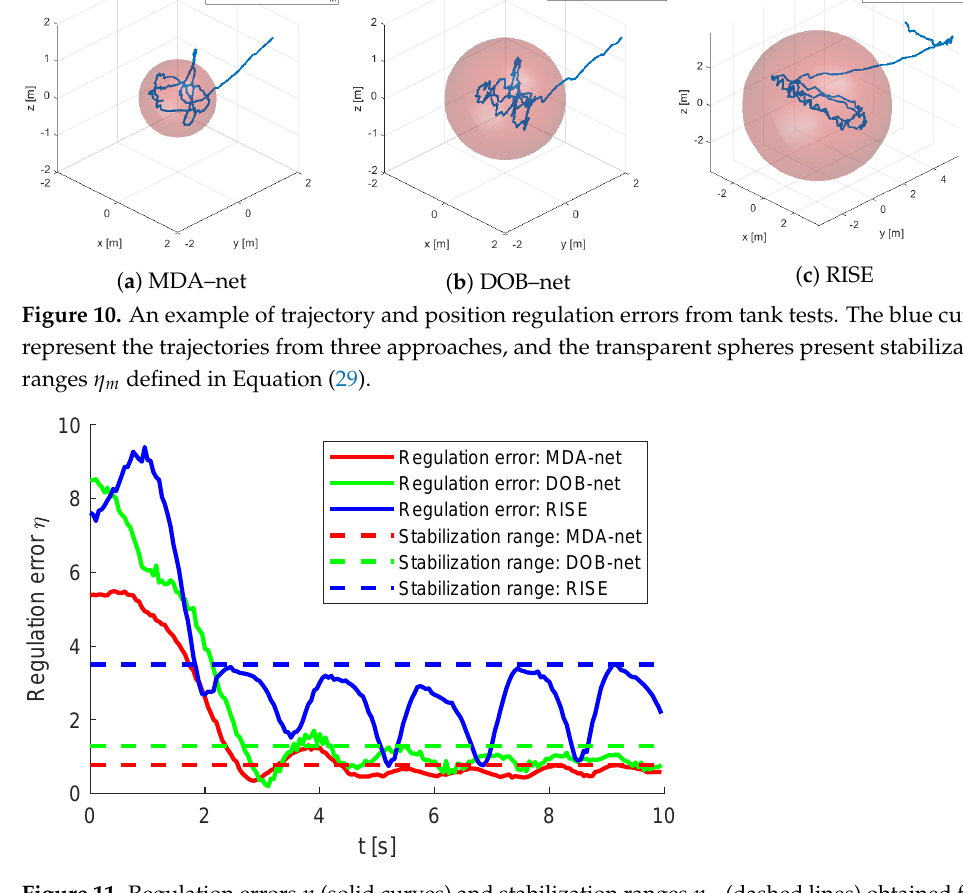
Figure 11. Regulation errors η (solid curves) and stabilization ranges η m (dashed lines) obtained from MDA–net (in red), DOB–net (in green), and RISE (in blue),